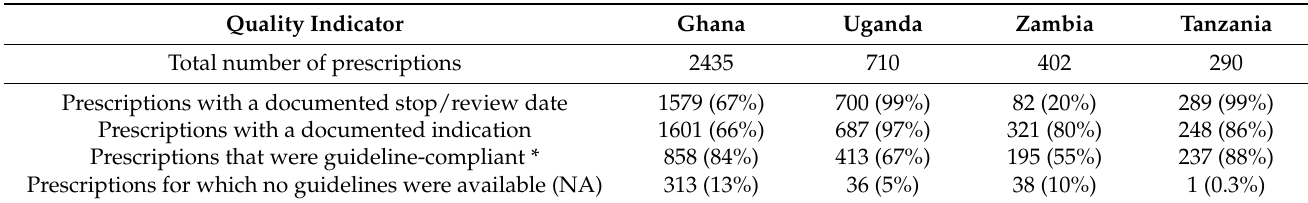
Table 6. Proportion of total prescriptions of all antimicrobials for each of the 4 quality indicators (% of total). Quality